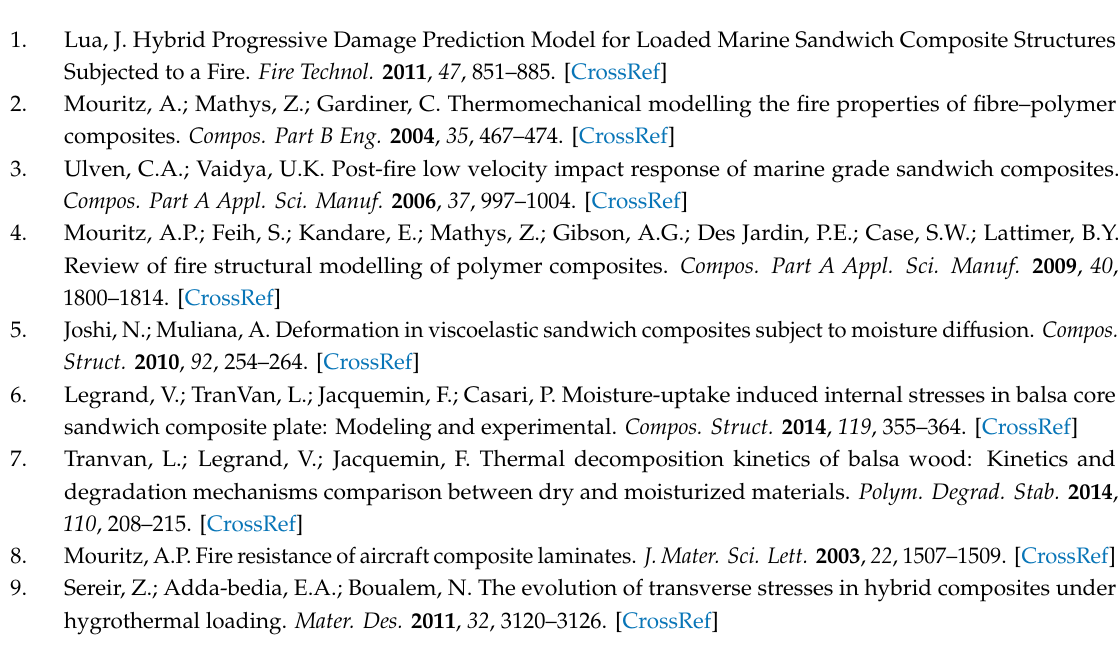
Figure 10. Cross-section of the sandwich structured composite beam after 100 s exposed to fire for the dry specimen ( a ) and the moisture saturation specimen ( b ).